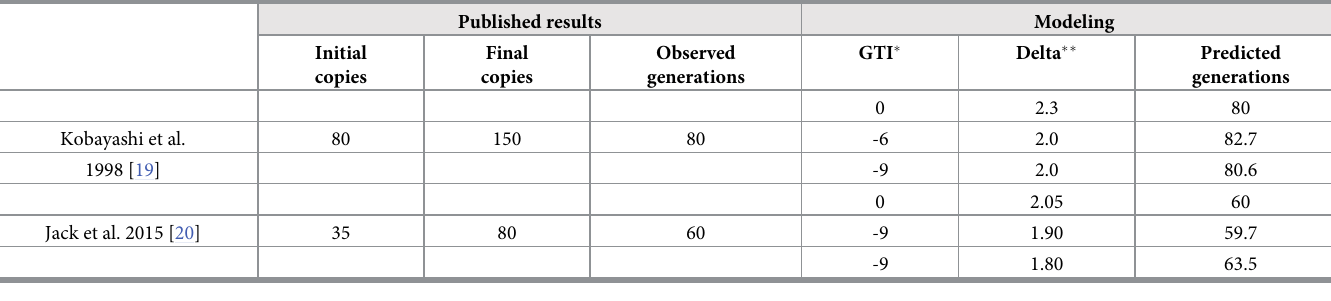
Table 2. Several alternative possibilities using the Model B1 parameters to fit published experimental